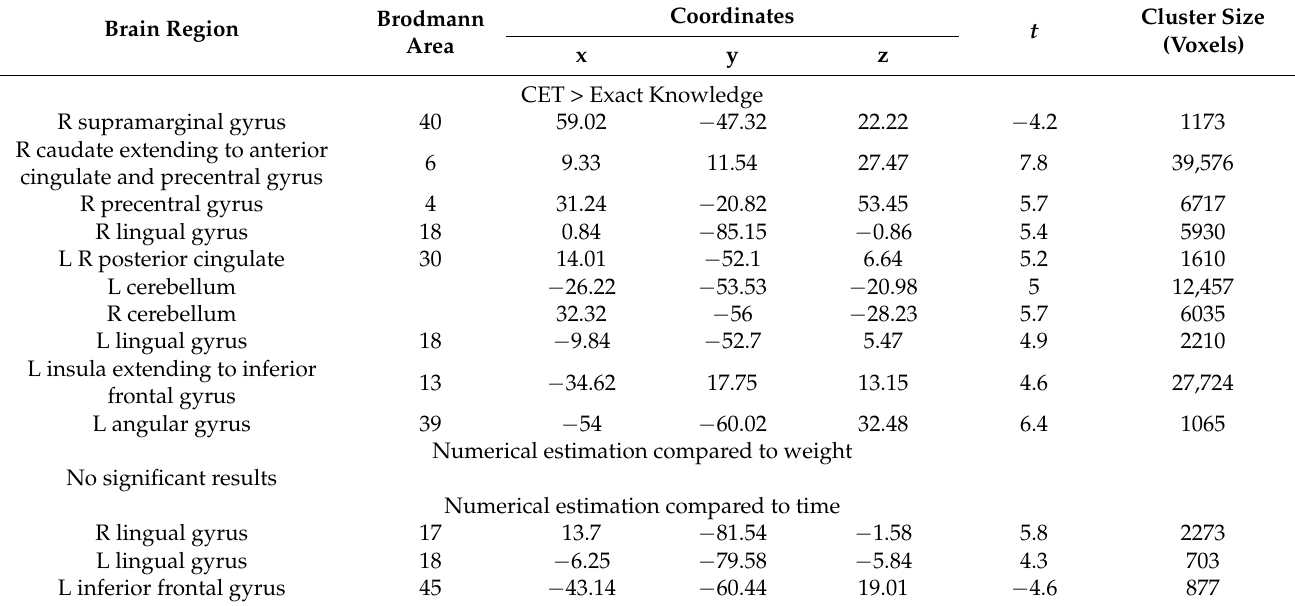
Table 1. Brain Region by